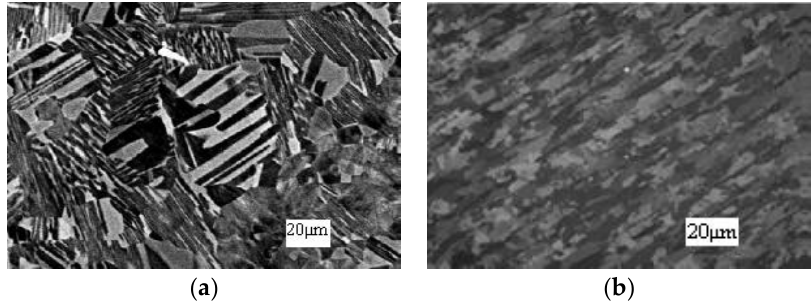
Figure 1. MoCuSi ( a ) ingot and ( b ) extruded. (courtesy of GfE ® Metalle und Materialien GmbH).